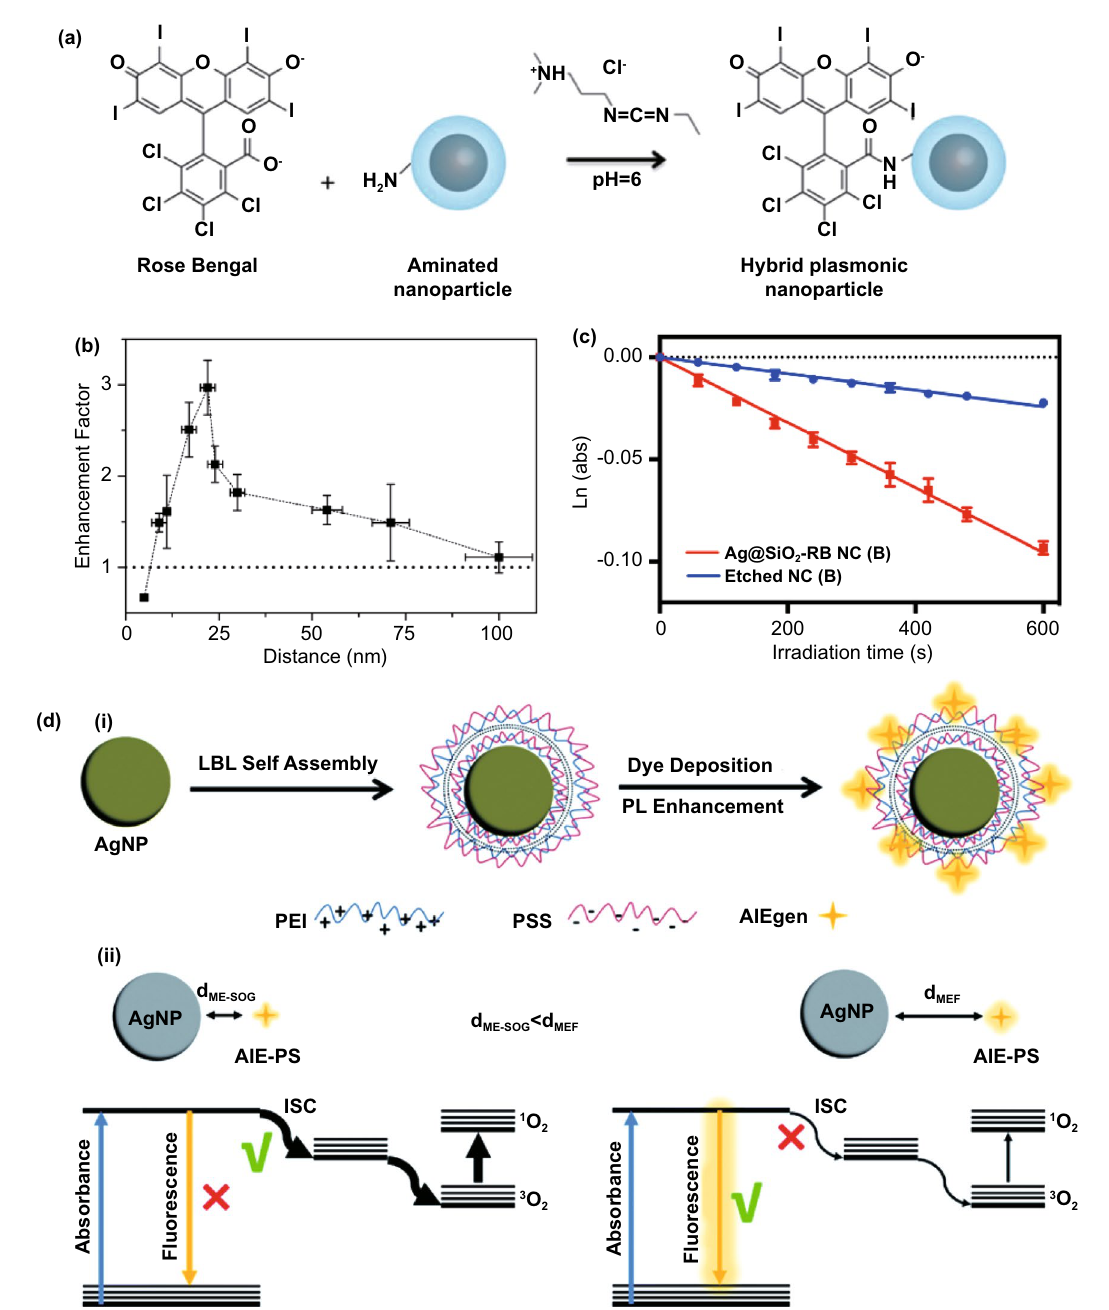
Fig. 14 a Chemical bonding of Rose Bengal to aminated metal@silica nanoparticle, reproduced from Ref. [223] with permission from Ameri- can Chemical Society. b Distance-dependent ME-SOG of Rose Bengal on 67 nm Ag nanoparticle coated with silica shell, reproduced from Ref. [223] with permission from American Chemical Society. c The first-order kinetic data for degradation of ABDA molecules in the presence of Rose Bengal molecules bonded on silver nanocube coated with silica shell (Ag@SiO 2 -RB NC) and the etched sample as control, and under similar white light irradiation, reproduced from Ref. [224] with permission from American Chemical Society. d (i) Layer-by-layer approach to control the distance between metal core and photosensitizer by tuning the thickness of dielectric bilayer on metal nanoparticles surface. (ii) Sim- plified Jablonski diagrams showing the MEF (right scheme) and ME-SOG (left scheme) mechanism of the AIE-PS nanohybrids occur at differ- ent optimum AgNPs to AIE-PS distance for maximum plasmonic enhancement, reproduced from Ref. [20] with permission from Royal Society of